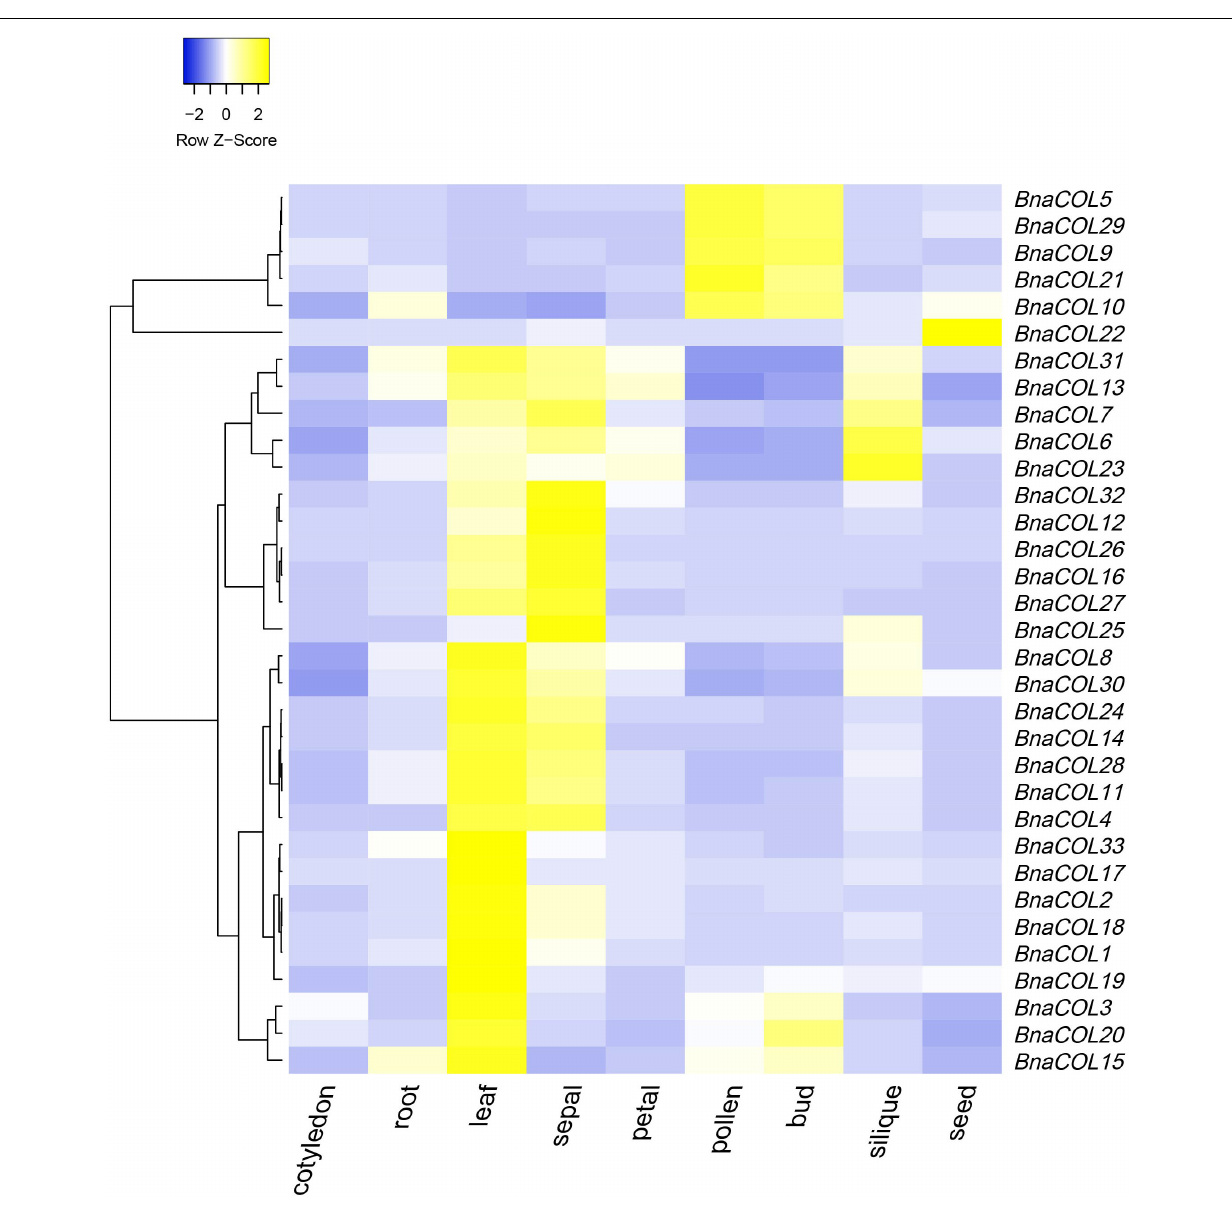
FIGURE 7 | The heat map shows the expression profile of BnaCOL genes in different tissues. The transcriptome data origins from the online website (BnTIR: Brassica napus transcriptome information